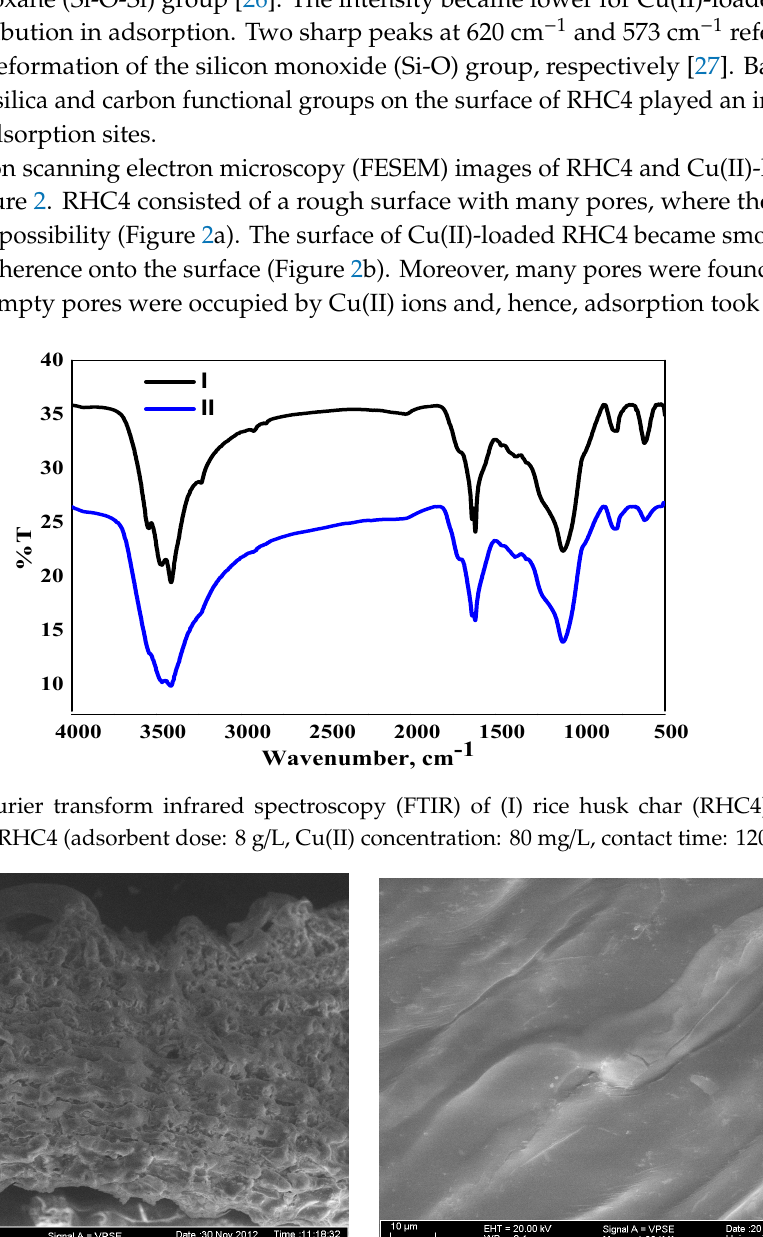
Figure 2. Scanning electron microscopy ( SEM) images of ( a ) RHC4 and ( b ) Cu(II)-loaded RHC4 (adsorbent dose: 8 g/L, Cu(II) concentration: 80 mg/L, contact time: 120 min).